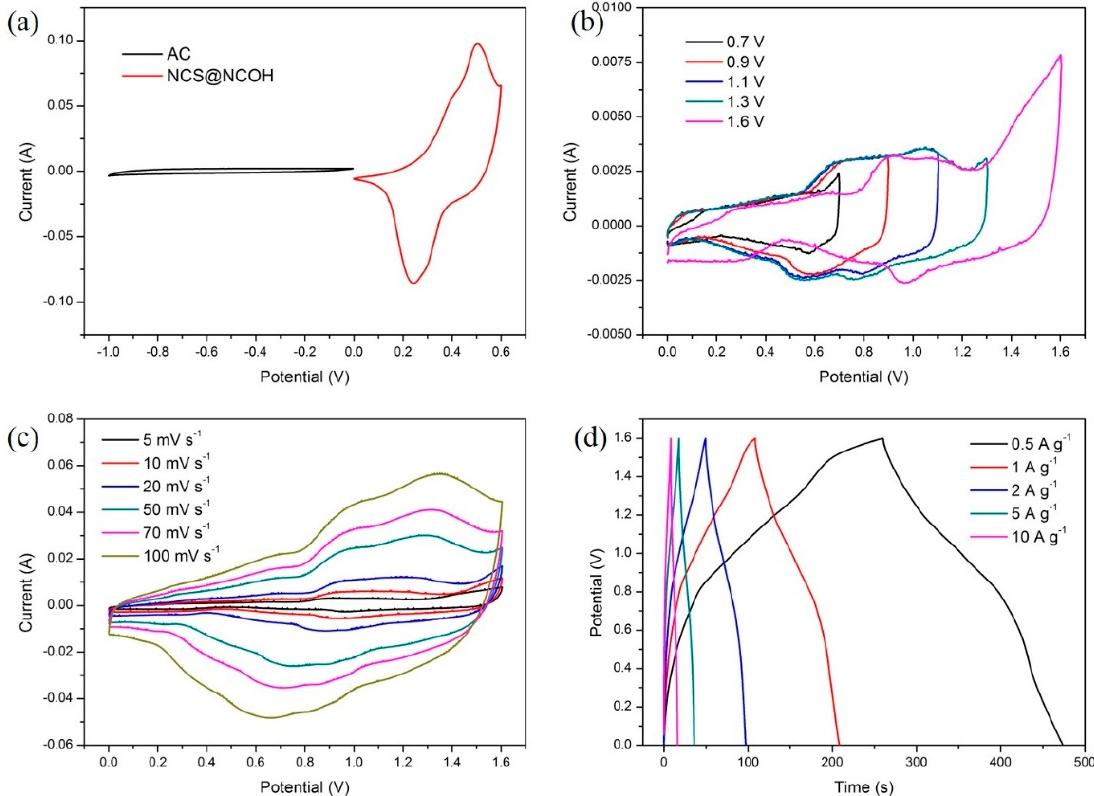
Figure 11. ( a ) CV curves of AC and NCS@NCOH at a scan rate of 5 mV s − 1 , ( b ) CV curves with different scan voltage windows, ( c ) CV curves of NCS@NCOH // AC at various scan rates, and ( d ) GCD curves of NCS@NCOH//AC at various current densities.